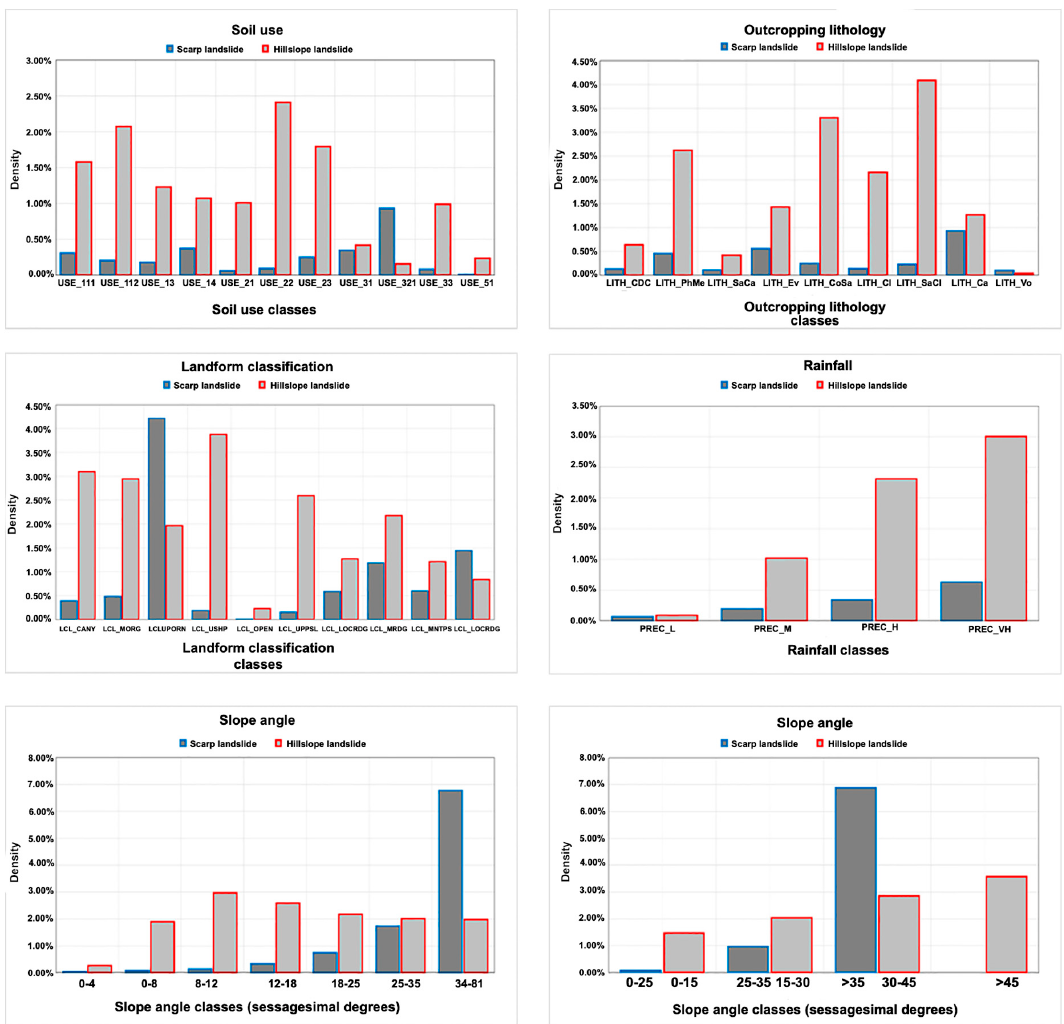
Figure 3. Univariate analysis for the continuous variables. Soil use . USE_111: continuous urban fabric; USE_112: discontinuous urban fabric; USE_13: transitional areas; USE_14: green urban areas; USE_21: arable land; USE_22: permanent crops; USE_23: heterogeneous agricultural areas; USE_31: USE_321: shrub and / or herbaceous associations; USE_33: open spaces with little or no vegetation; USE_51: water bodies. Landform classification. LCL_CANY: canyons; LCL_MDRG: midslope drainage; LCL_UPDRN: upland drainage; LCL_USHP: U-shaped valleys; LCL_PLAINS: plains; LCL_OPEN: open slopes; LCL_UPPSL: upper slope; LCL_LOCRDG: local ridge; LCL_MRDG: midslope ridge; LCL_MNTPS: mountain tops. Rainfall (mm). PREC_L: 0–450; PREC_M: 450–600; PREC_H: 600–800; PREC_VH: > 800. Slope Angle (scarp landslide). SLO_L: 0 ◦ –25 ◦ ; SLO_M: 25 ◦ –35 ◦ ; SLO_H: > 35 ◦ ;